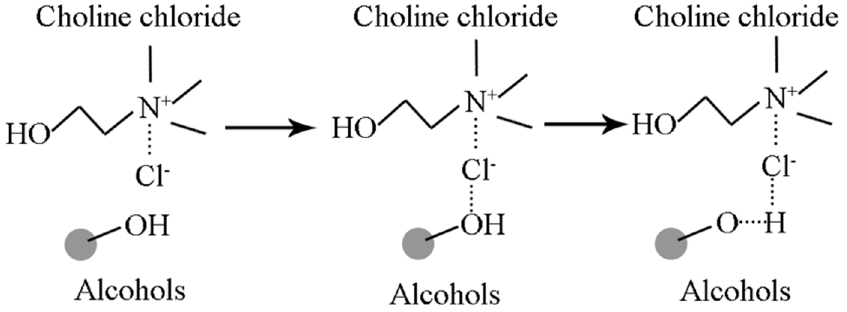
Figure 1. Schematic illustration of the formation mechanism of choline chloride and hydrogen bond in deep eutectic solvents (DESs).